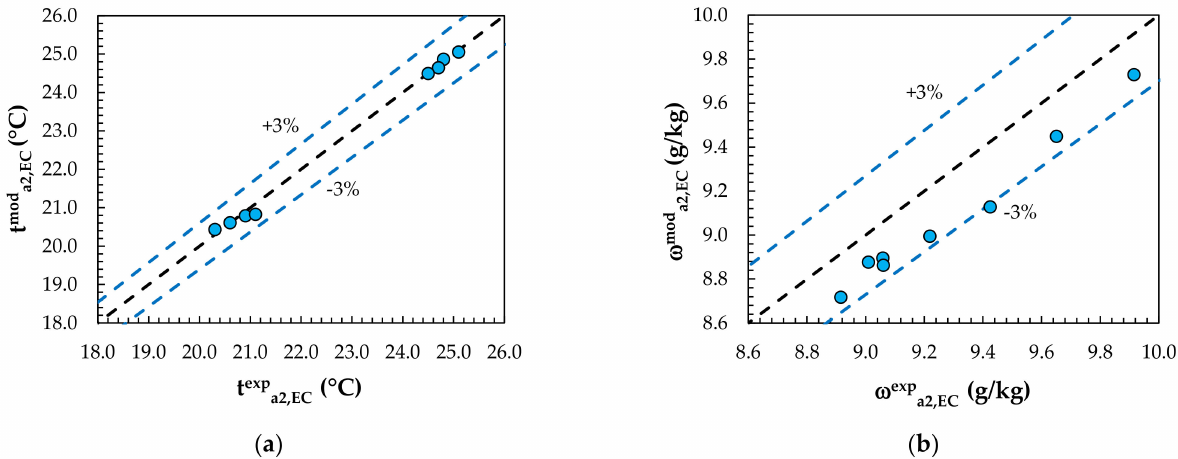
Figure 4. Comparison of model values with experimental results for evaporative cooling: ( a ) outlet air temperature; ( b ) outlet air humidity